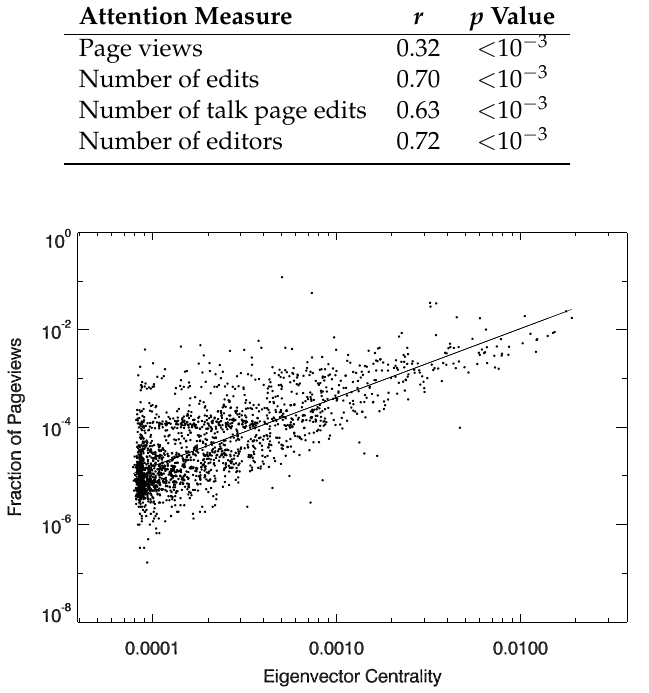
Figure B.1. The relationship between EC of a page and the percent of the network’s page views it